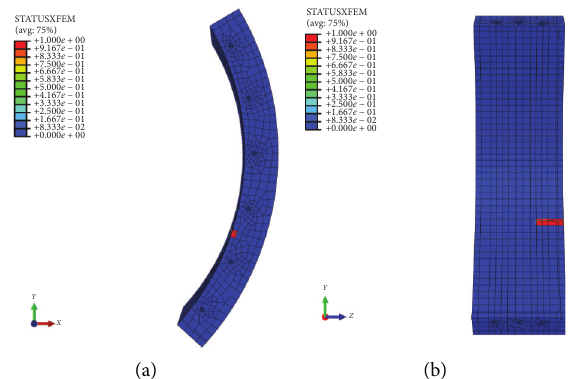
Figure 6: The initial crack in the shield tunnel segment.